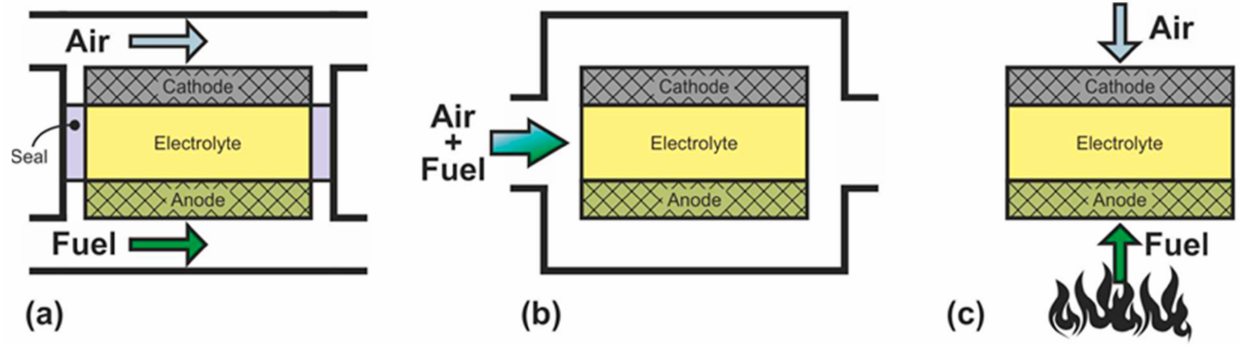
Figure 2. Schematics of ( a ) dual-chamber SOFC, ( b ) single-chamber SOFC, and ( c ) no-chamber